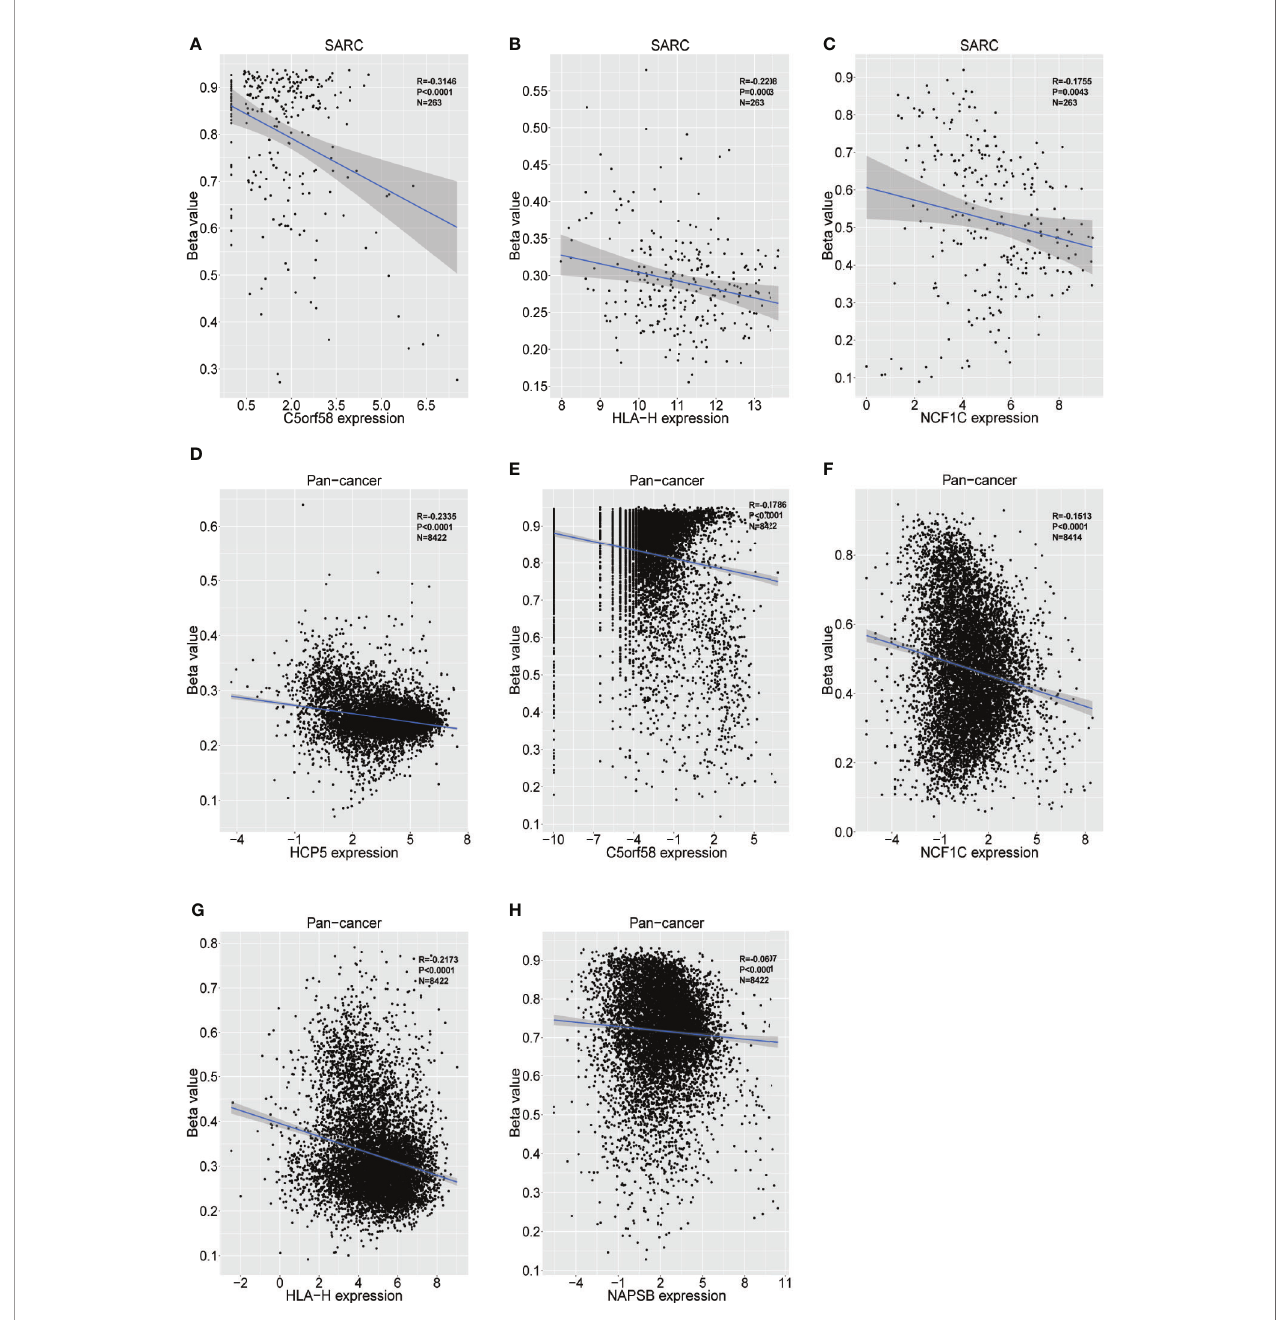
FIGURE 6 | Relationship between the expression of ICLs and DNA methylation in sarcoma and pancancer. (A – C) Correlation of C5orf58/HLA-H/NCF1C expression and DNA methylation in sarcoma. (D – H) Correlation of HCP5/C5orf58/NCF1C/HLA-H/NCF1B expression and DNA methylation across